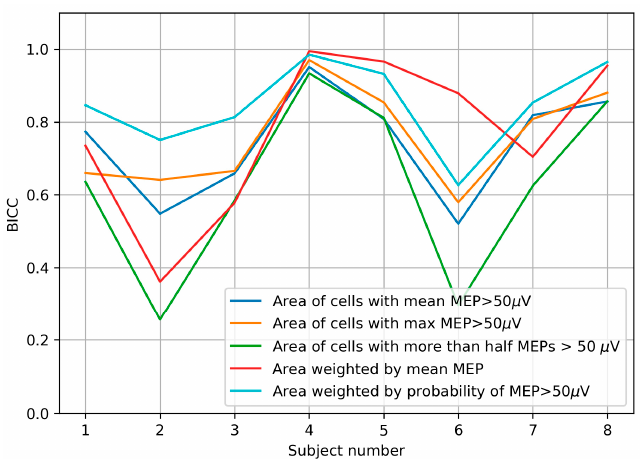
Figure 7. Bootstrapping-based between-session intraclass correlation coefficient (BICC) calculated for all the area and weighted area variants in all subjects.